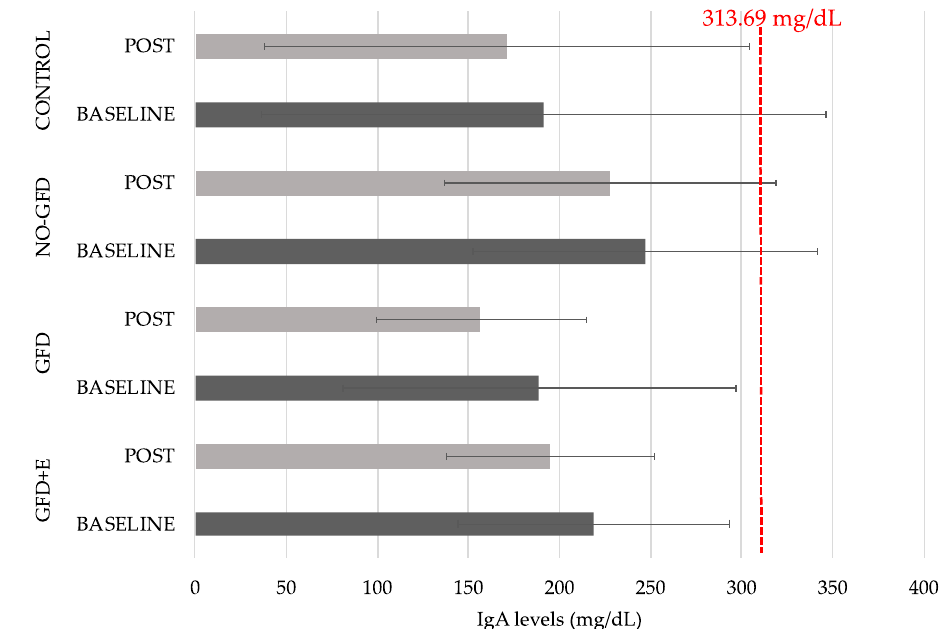
Figure 5. Descriptive statistics of blood IgA levels before and after intervention: GFD + E, celiac women with nutritional plan and physical exercise; GDF, celiac women with nutritional plan; NO-GFD, celiac women without nutritional plan or physical exercise; control, healthy women without dietary intervention or physical exercise. Reference values range from 43.63 mg/dL to 583.75 mg/dL, with a mean of 313.69 mg/dL [23].